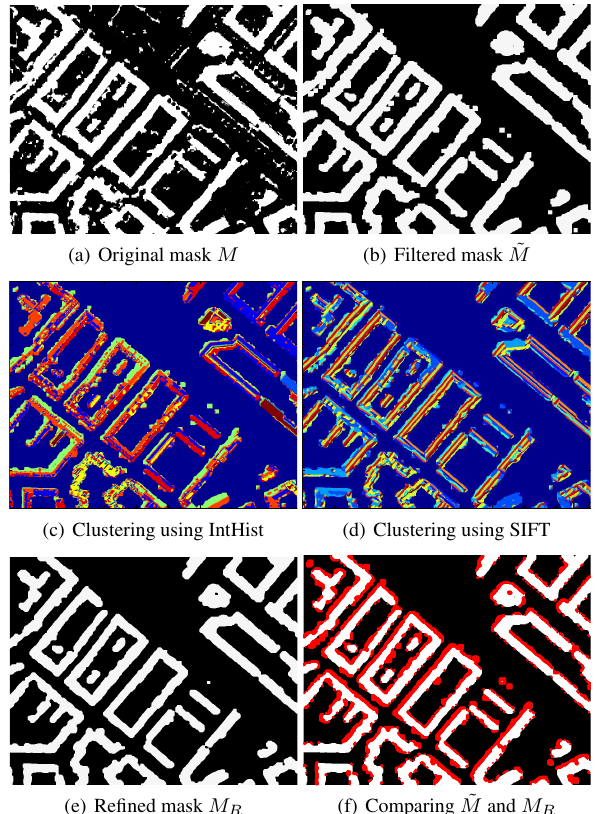
Figure 3: Refining the mask M for the high resolution image I by employing morphological filtering and clustering. The refined mask M R represents finer details of the building boundaries.